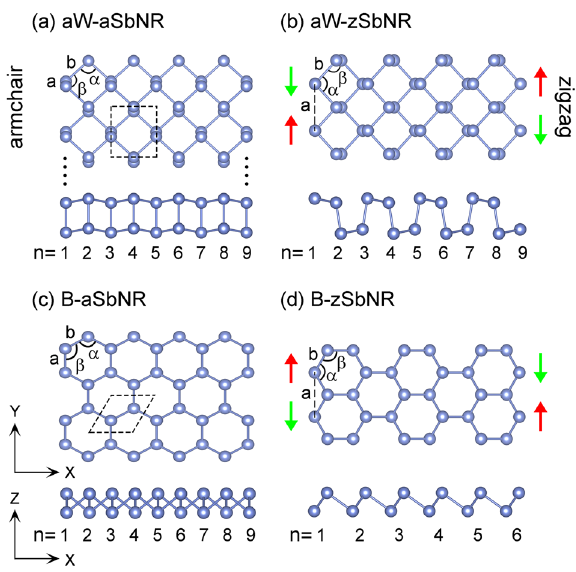
Fig. 1 Top and side views of a aW-aSbNR, b aW-zSbNR, c B-aSbNR, and d B-zSbNR. Initialization of edge magnetism is depicted by green (spin down) and red (spin up) arrows Table 1. Values of relevant structural parameters a , b , α , and β in Fig. 1 and magnetic moments of Sb1 ~ Sb4 atoms in Fig. 2a, b Lattice parameters (Å/deg)